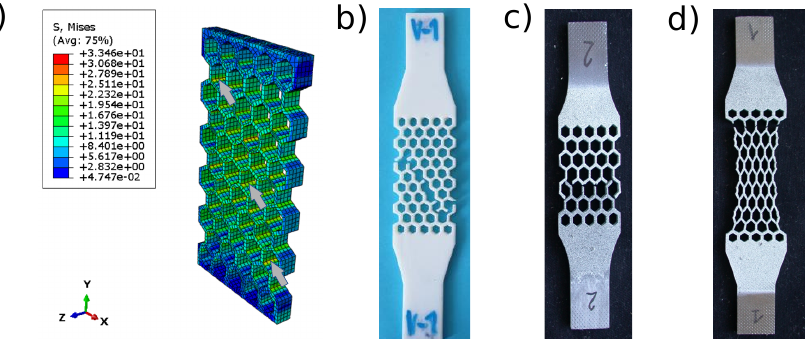
Figure 5. ( a ) von Mises stress distribution for Stratasys Vero PureWhite specimen loaded by the axial tensile force of 200 N. Value of stress is expressed in MPa. Values of stress are expressed in MPa. Maximum stress is identified at connecting nodes of individual honeycomb cells. Few nodes with stress concentration are marked by arrows. Experimental specimens from Stratasys Vero White polymer ( b ), titanium alloy Ti6Al4V ( c ) and stainless steel 316L ( d ) show fractures at connecting